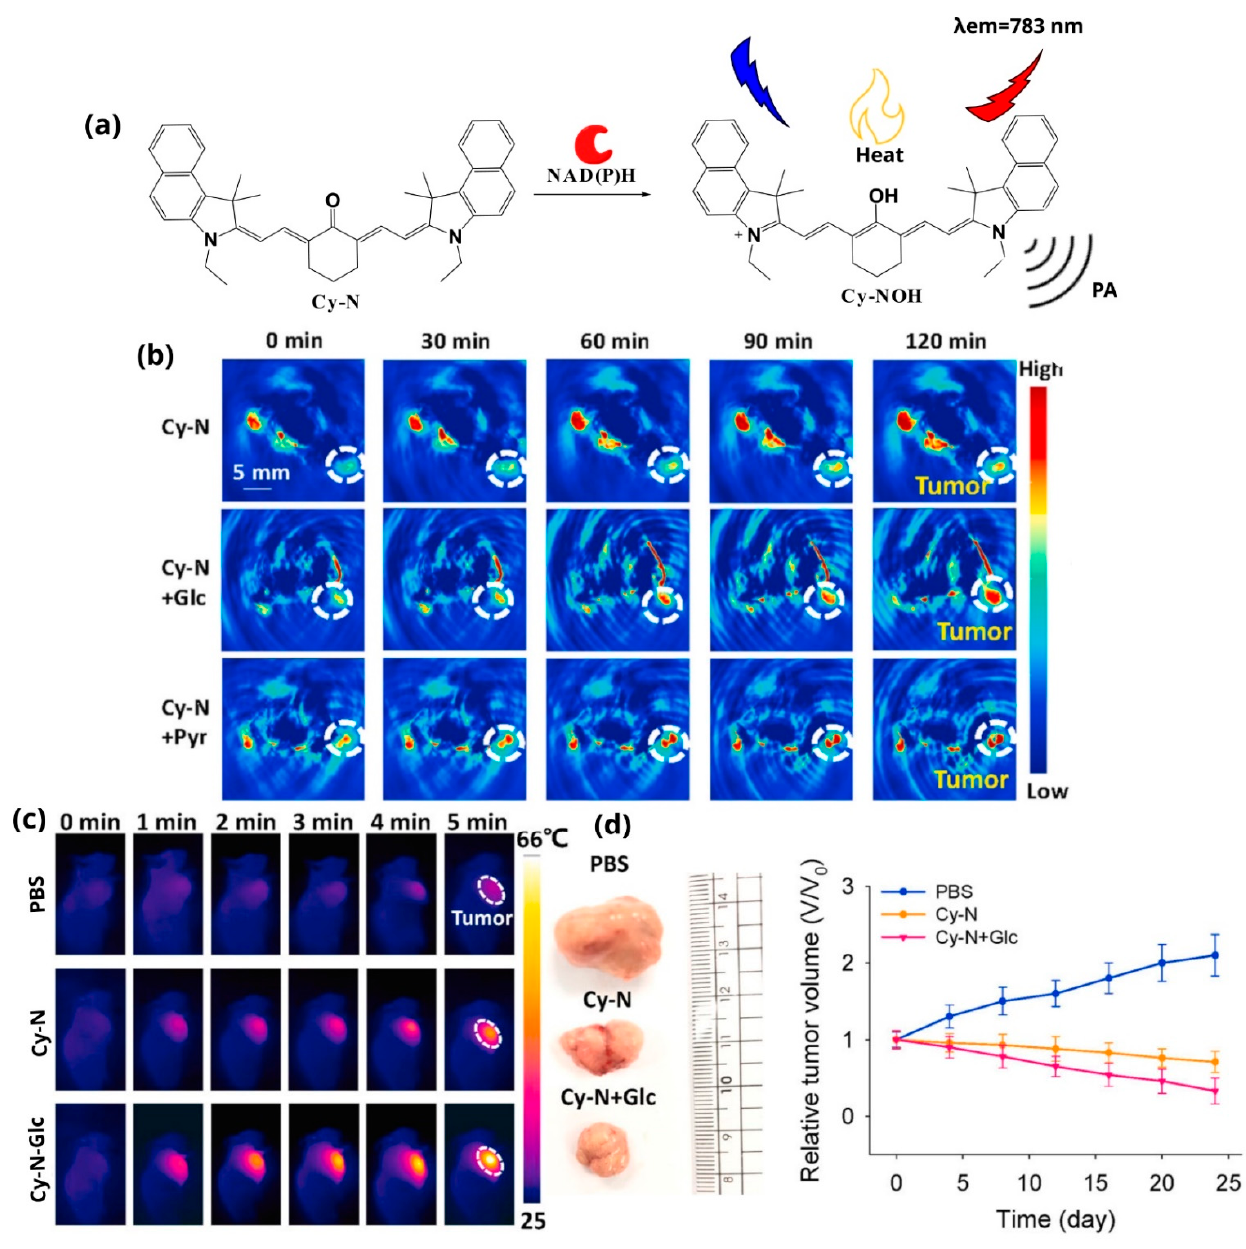
Figure 12. ( a ) Schematic illustration of the interaction mechanism of Cy-N with NAD(P)H to exert its effect; ( b ) the time-dependent PAI imaging of tumor-bearing mice; ( c ) PTT effect of the Cy-N probe against tumor-bearing mice after irradiation at 660 nm; ( d ) photographs of the excised tumors and tumor growth curves of the tumor-bearing mice using PTT and different treatments. Adapted with permission from [127], Elsevier, 2021.